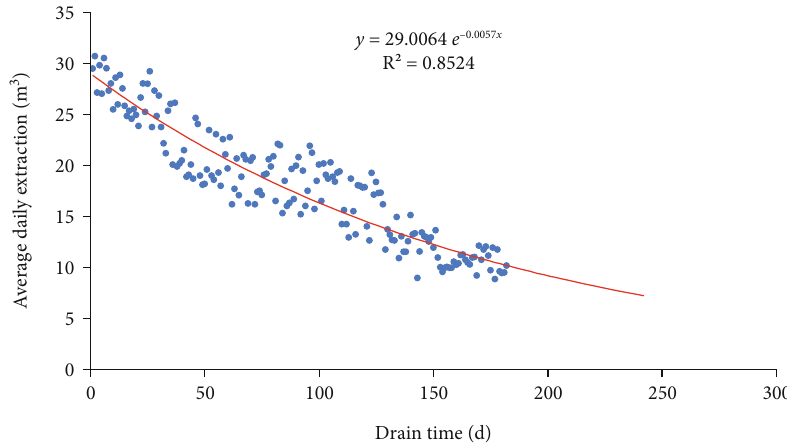
Figure 23: Variation curve of daily average extraction scalar volume with time in slotted